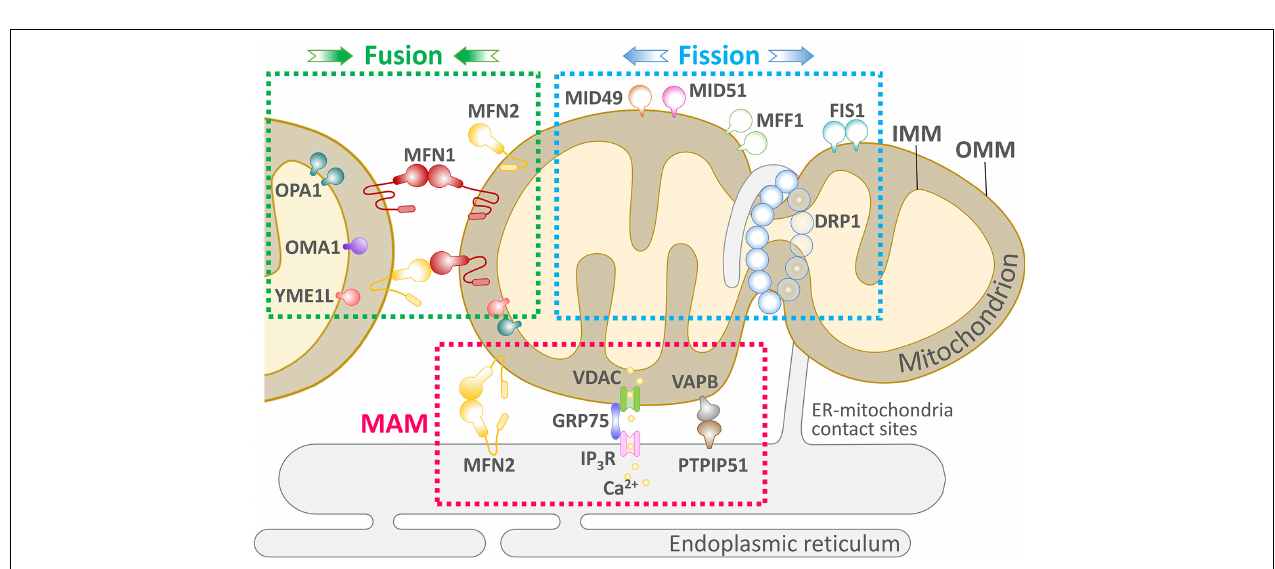
FIGURE 1 | An overview of the key components of mitochondrial dynamics-ER communication and maintenance of cellular physiology. Mitochondria undergo two successive and opposite processes related to membranes: fission and fusion. Depending on the cellular environment and circumstances, the balance between fission and fusion can change, and the balance tends to favor one of these two processes. When cells are subjected to mild stress, mitochondria form an elongated and interconnected network to adapt to nutrient deficiencies while adapting to cellular stress. In contrast, under severe stress, mitochondria present a fragmented shape. Mitochondria and ER are in close proximity to each other and form the MAM. The MAM allows efficient Ca 2 + -stable exchange between the ER and mitochondria through the IP 3 R, VDAC mitochondrial calcium unidirectional transport protein (MCU) and PTP. Several proteins involved in mitochondrial fission, such as Mff and Fis1 mediate the localization of Drp1 on the ER, suggesting the existence of other unknown pathways to control ER-controlled mitochondrial